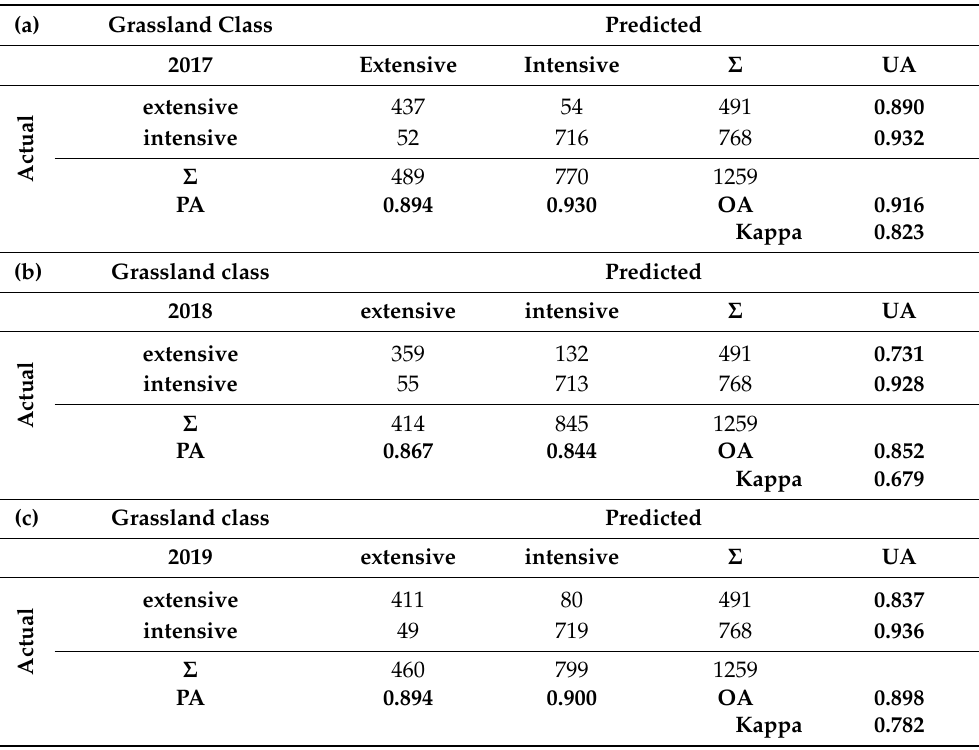
Table 5. Confusion matrices of the annual SITS (all available Sentinel-1, Sentinel-2 and environmental variables) for the accuracy of the reference dataset with RF classifier (UA: User’s Accuracy, PA: Producer’s Accuracy, OA: Overall Accuracy). ( a ) is for the year 2017, ( b ) for the year 2018 and ( c ) is for the year